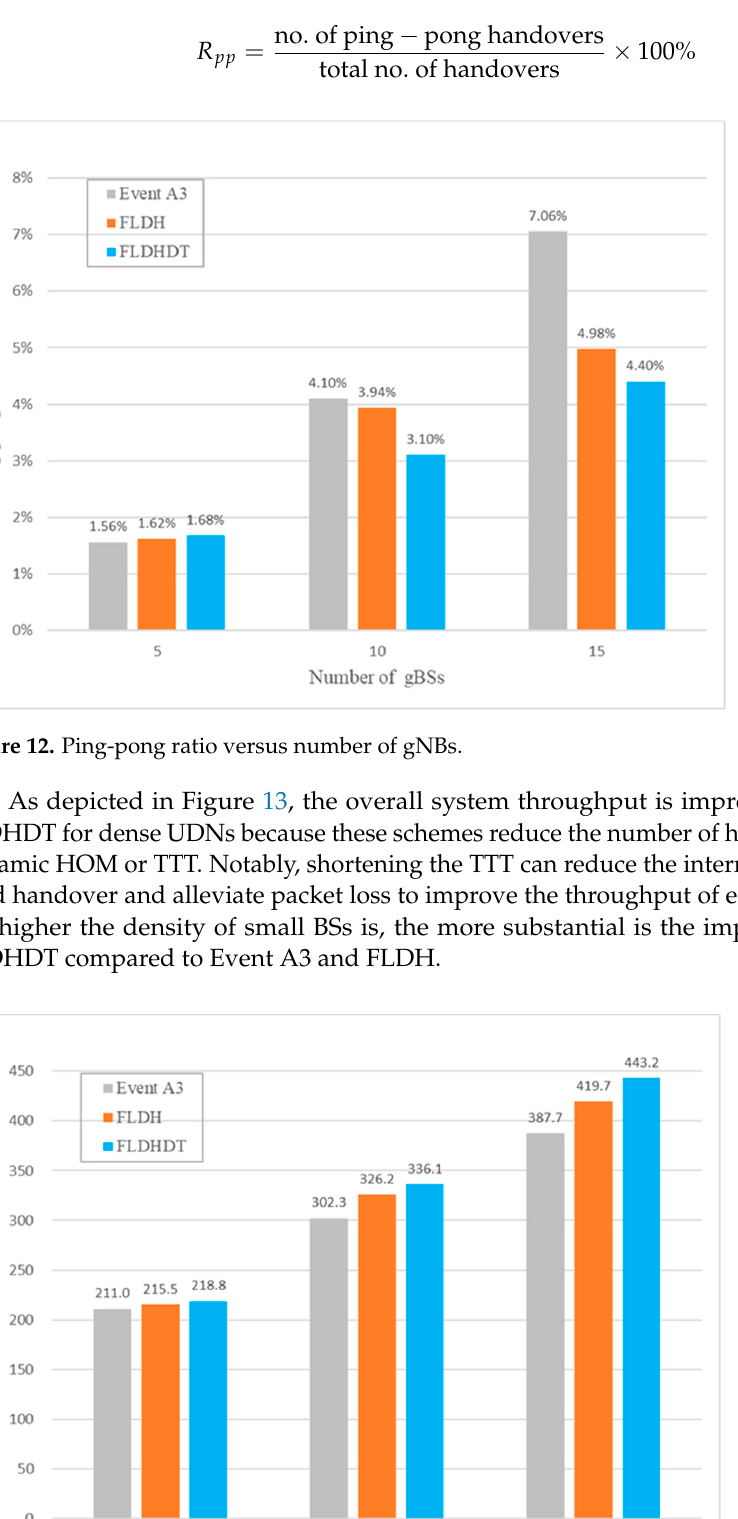
Figure 13. System throughput versus number of gNBs.